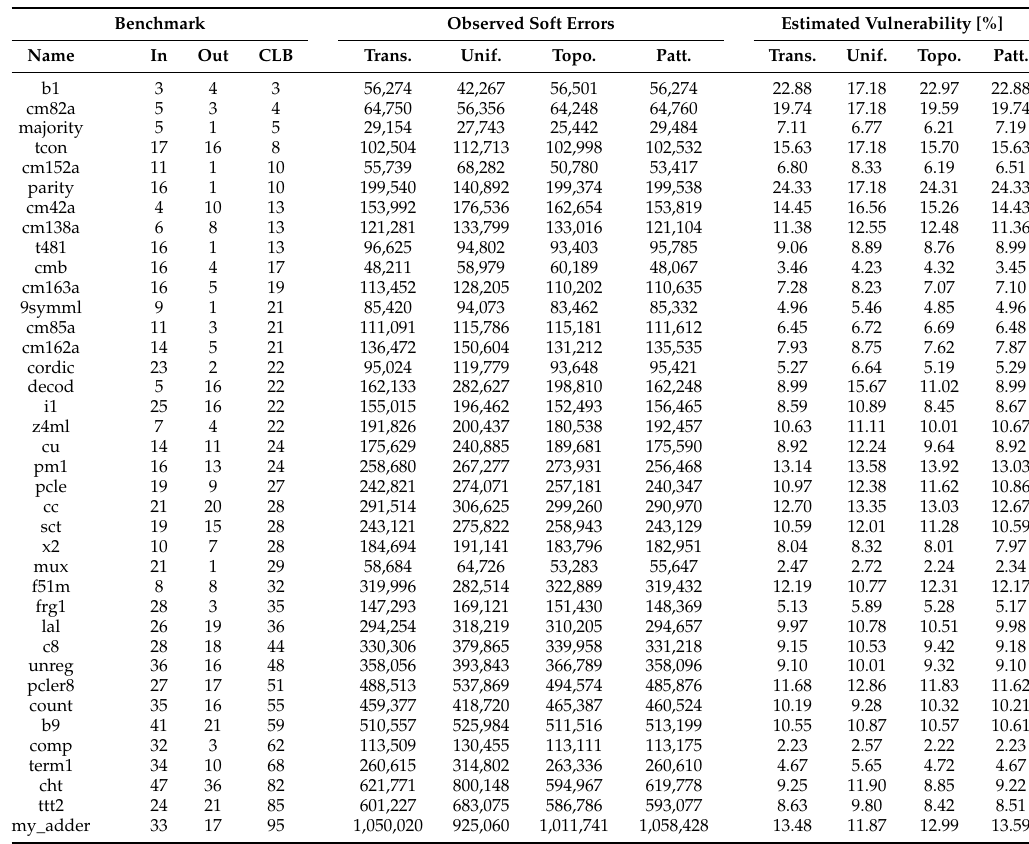
Table 2. Combinational benchmark circuits—Characteristics and SEV estimation results. For each benchmark, the table presents (i) their number of inputs, outputs and CLBs required for the selected technology; and (ii) the number of observed SEs and the estimated SEV. Columns Trans. refers to the results at the transistor level; Unif., to uniform distribution, ignoring the SET susceptibilities; Topo., for considering only the topology effect; and Patt., for considering both Input patterns and topology